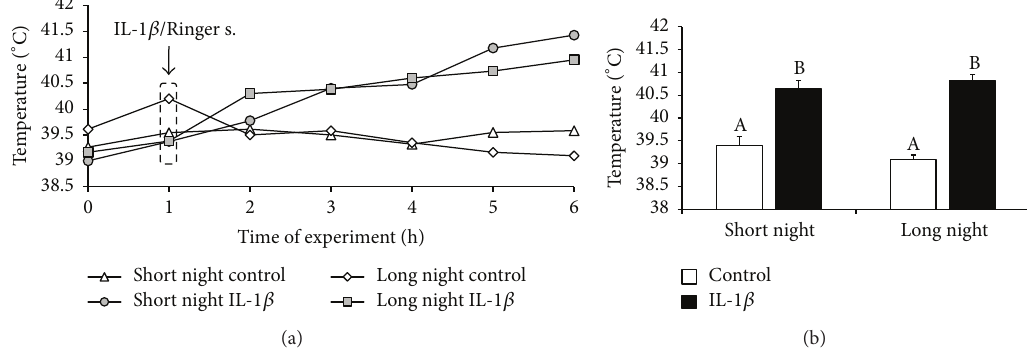
Figure 1: The effects of intracerebroventricular injection of interleukin- (IL-) 1 𝛽 (50 𝜇 g/animal) or Ringer’s solution (50 𝜇 L) on the rectal body temperature of ewes measured during the short night (SN, May/June) and long night (LN, November/December) photoperiods. Experiments started 1 hour after sunset. (a) presents the temporal patterns of rectal mean body temperature ( 𝑛 = 6 animals per group) measured in one- hour intervals. (b) depicts the mean ( ± SEM; 𝑛 = 6 animals per group) rectal body temperatures for the period after IL-1 𝛽 or Ringer’s solution treatment (1 to 4h) of ewes during the SN and LN photoperiods. Different capital letters indicate significant ( 𝑃 < 0.05 ) differences based on a two-way ANOVA followed by Tukey’s post hoc